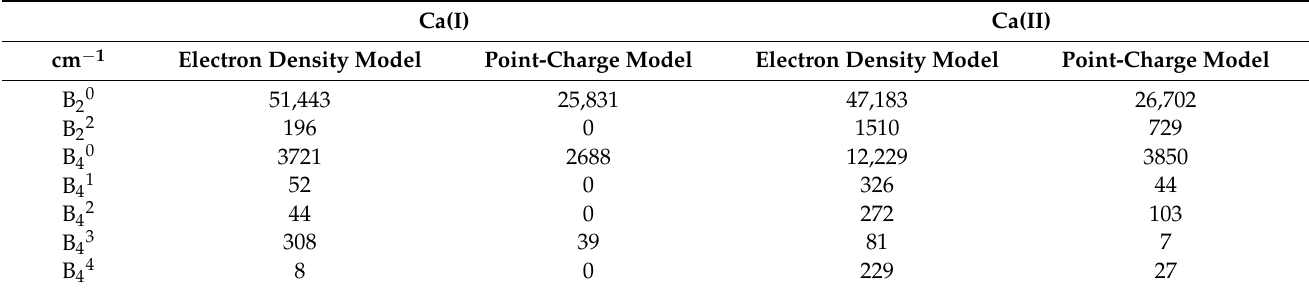
for two possible positions in different models. k